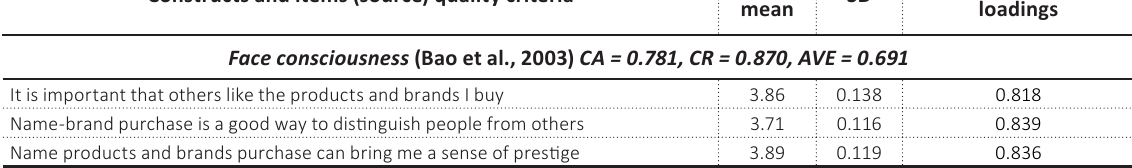
Table 1. Evaluation of measures Constructs and items (source) quality